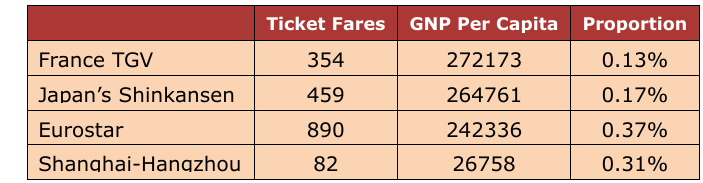
Table 2. Ticket Fares and the Proportion Accounting for GNP Per